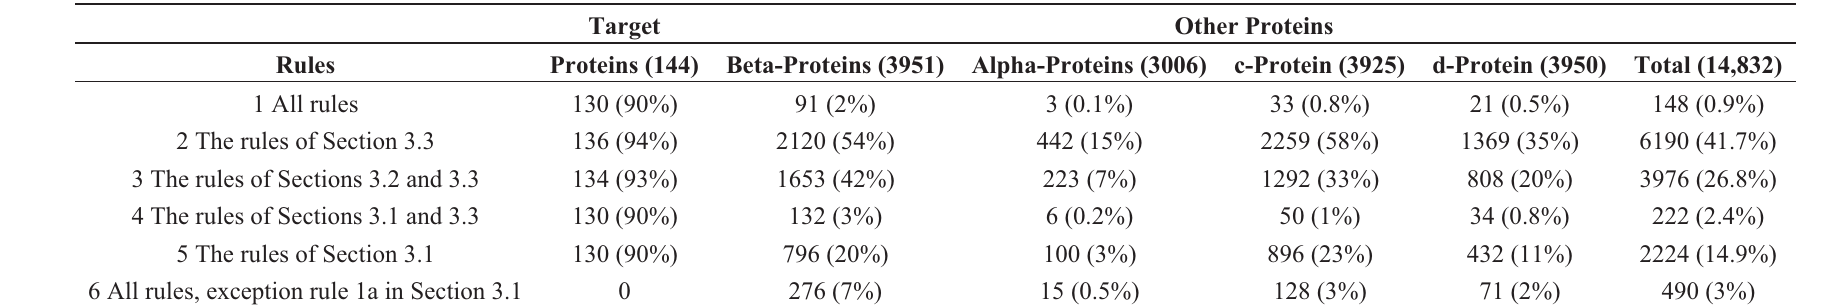
Table 4. Tests of specificity and